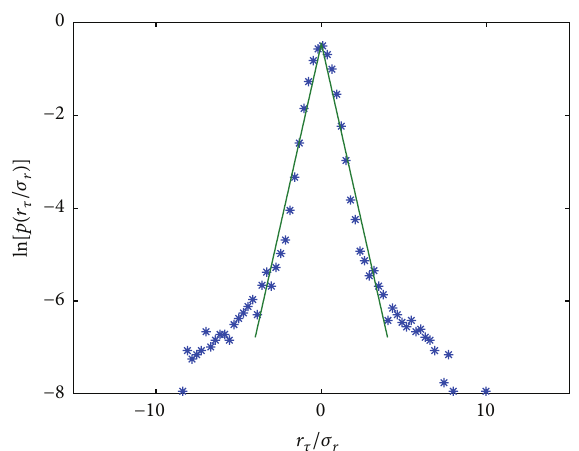
Figure 5: Distribution of returns with 𝜏 = 16 ( ∗ -line) in the case 𝐾 = const, and Laplace distribution (solid line).